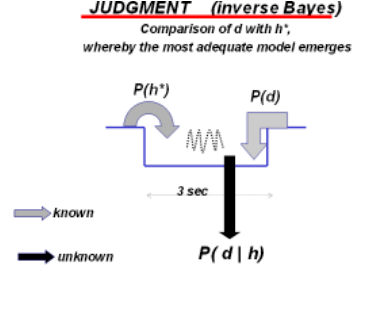
Figure 13. The inverse Bayes procedure that occurs in linguistic endeavors, whereby a previous piece ofa text is retrieved by the short term memory and compared with the next one: the appro- priate conditional probability is no longer stored permanently but it emerges as a result of the comparison (judgmentand consequent